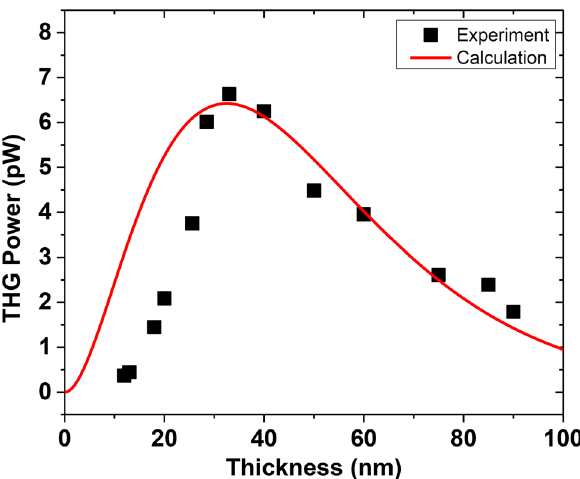
Figure 4. The dependence of THG emission power on the thickness of exfoliated SiP flake with the data fitting by Eq. (12). The black squares and solid red line refer to the experimental data and theoretical fitting,